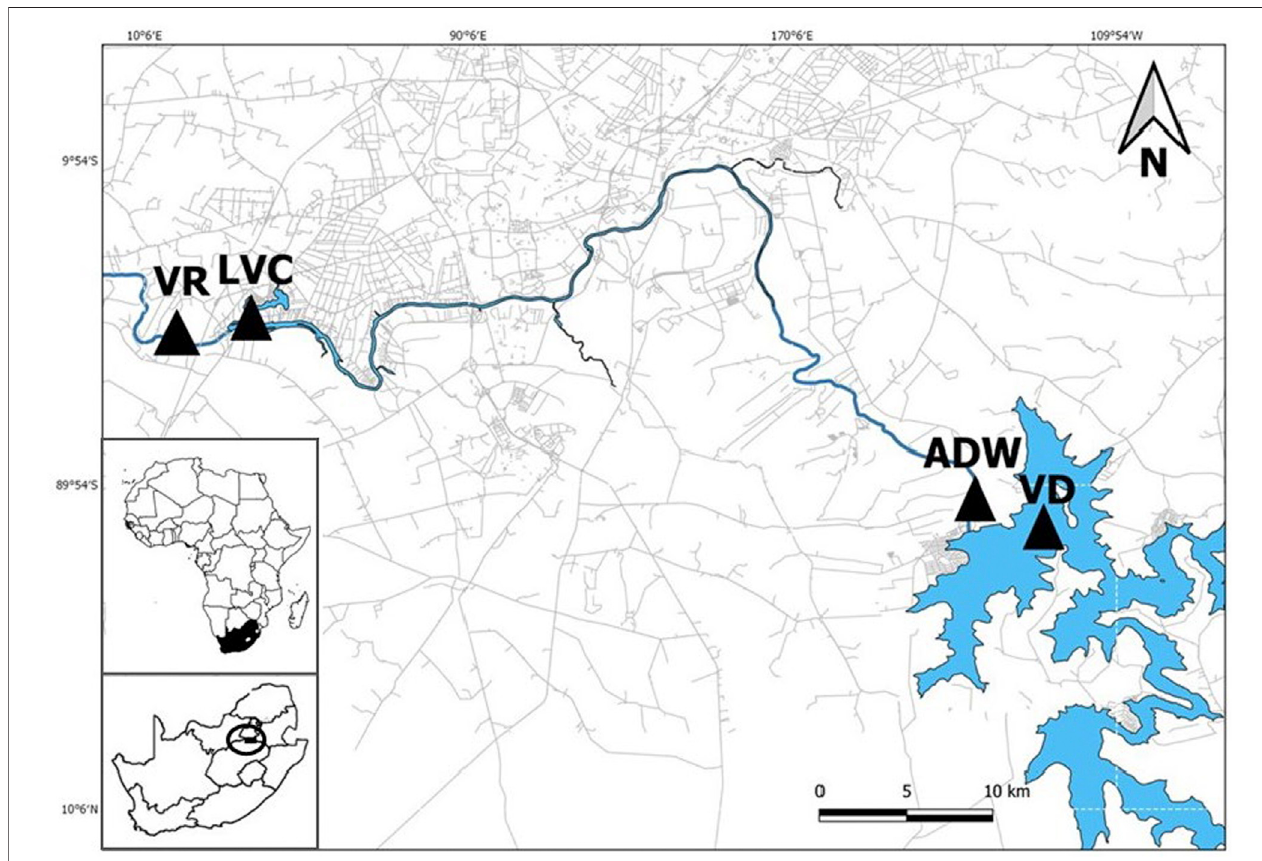
FIGURE 1 | Map of sites investigated in the upper Vaal River (Blue-water, grey-roadways). From upstream to downstream: VD- Vaal Dam, ADW- After Dam Wall, LVC- Loch Vaal Club, and VR- Vaal Rus.